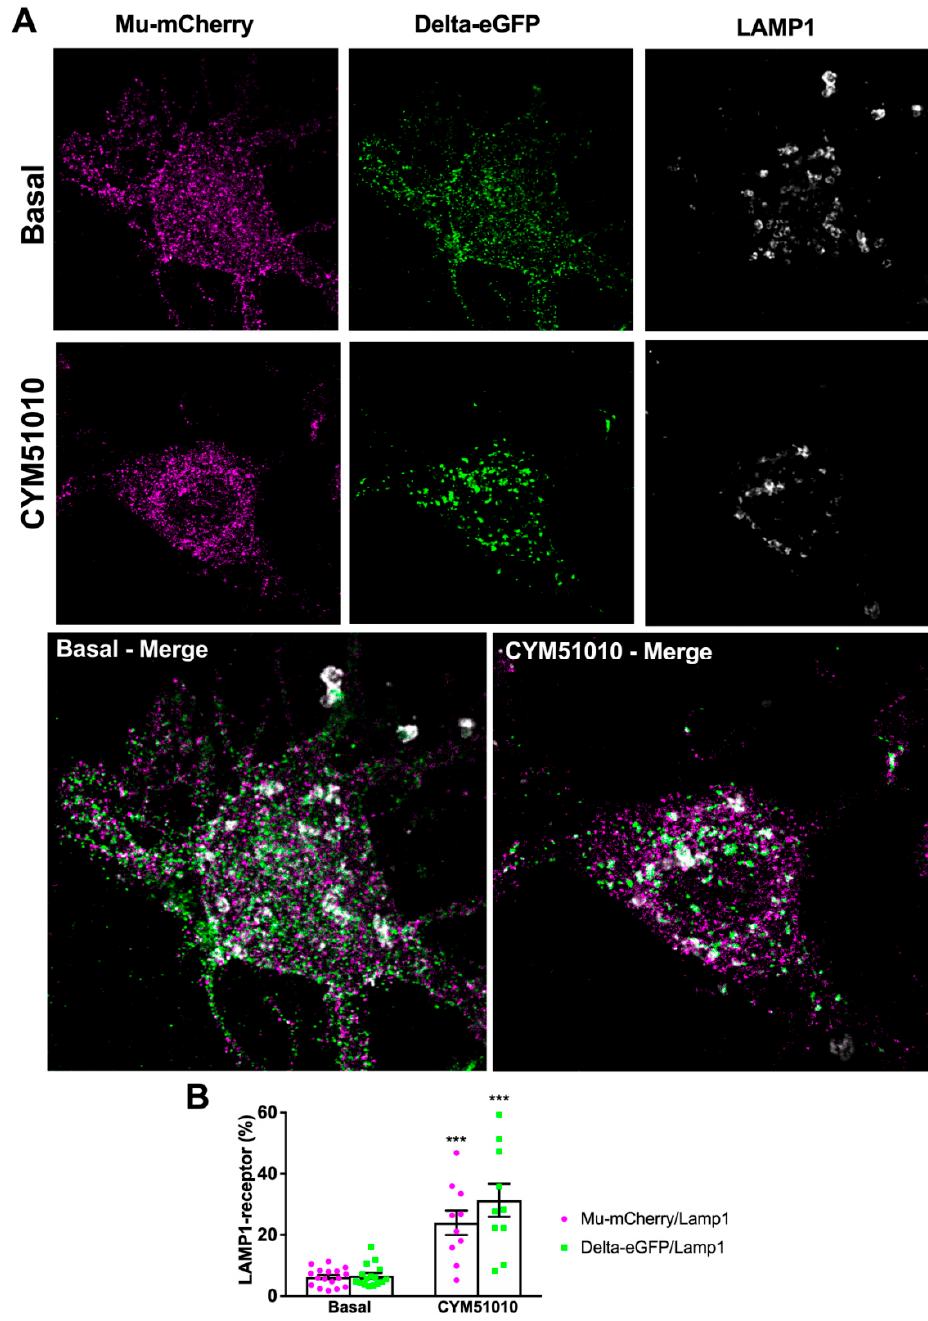
Figure 2. Mu and delta opioid receptors co-localize in the lysosomal compartment upon CYM51010 activation in primary hippocampal cultures. ( A ) Representative confocal images showing mu-mCherry–delta-eGFP colocalization with LAMP1 immunoreactive compartment under basal conditions or 60 min after CYM51010 application (400 nM). Scale bar = 10 µ m (inset scale bar = 2.5 µ m). ( B ) Drug treatment induces statistically significant increase in the amount of colocalization of mu-mCherry / delta-eGFP colocalization with LAMP1 labeling. Two-way ANOVA F drug treatment (1, 49) = 62.70; p < 0.0001. F receptor (1, 49) = 2.12, p = 0.15; F interaction (1, 49) = 3.65, p = 0.2. Tukey’s post hoc test: *** p < 0.001 for both mu-mCherry and delta-eGFP; n = 10–20 neurons per group from at least three independent